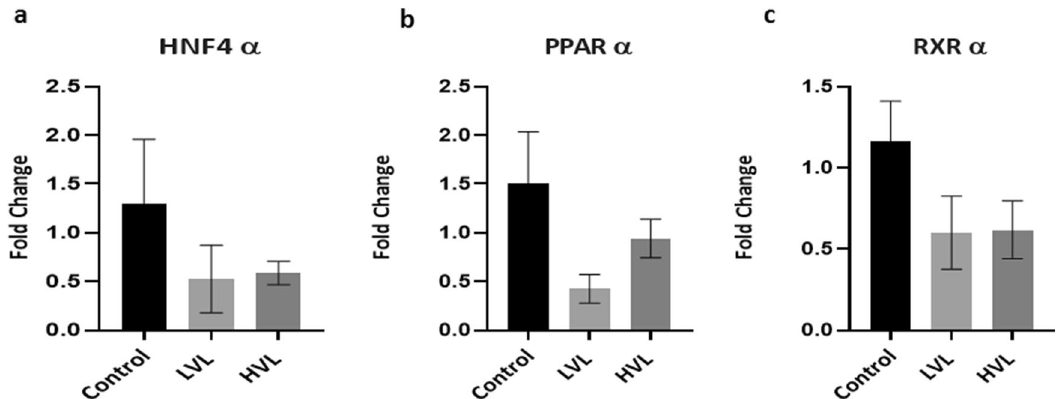
Figure 6. Differential expression of host transcription factors. mRNA levels of ( a ) HNF4α, ( b ) PPARα and ( c ) RXRα in placenta from the groups. HVL High Viral Load Group, LVL Low Viral Load Group, HNF4α Hepatocyte Nuclear Factor 4α, PPARα Proliferator Activated Receptor α, RXRα Retinoid X Receptor